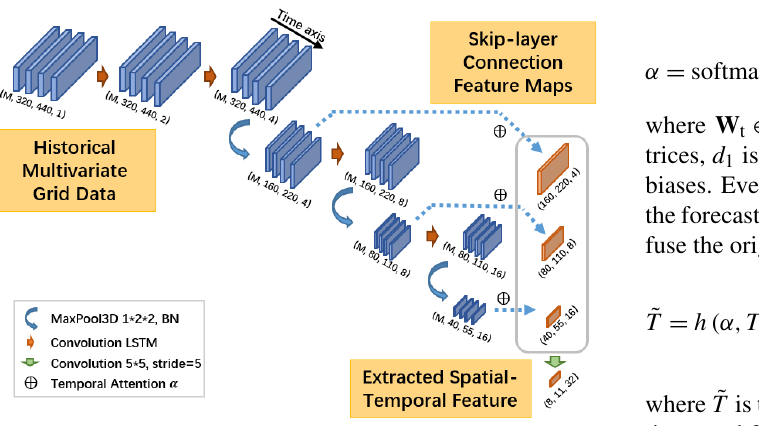
Figure 5. A detailed structure for encoder: a stacked ConvLSTM encoder for extracting spatial–temporal features simultaneously. There is also temporal attention weight for skip-layer connections in the grey